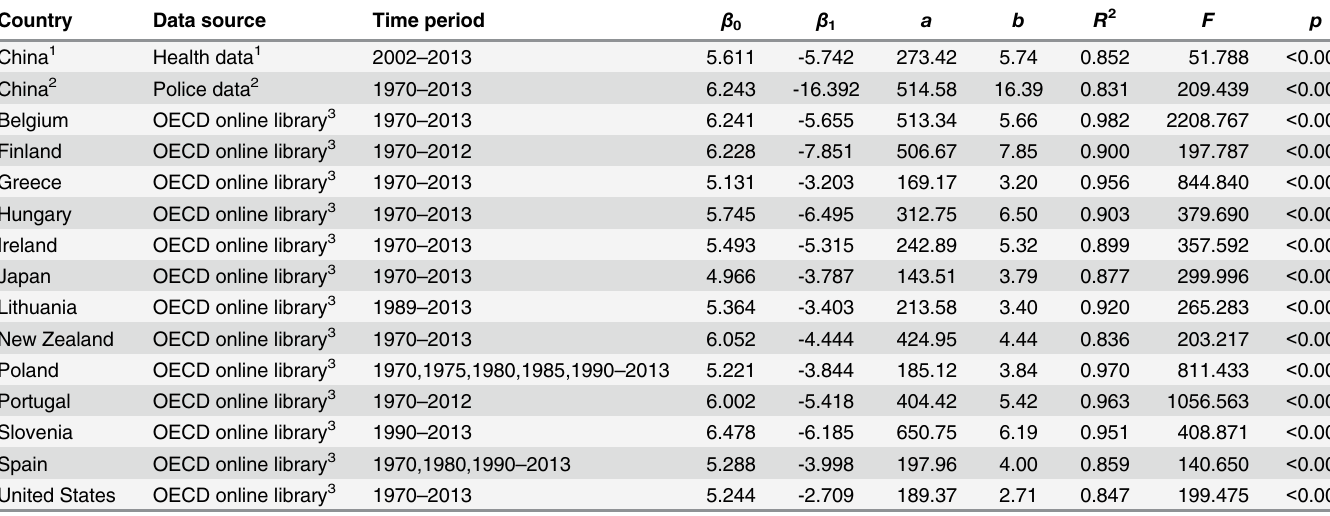
Table 1. Model fit of modified Smeed equation using the data of China and 13 selected